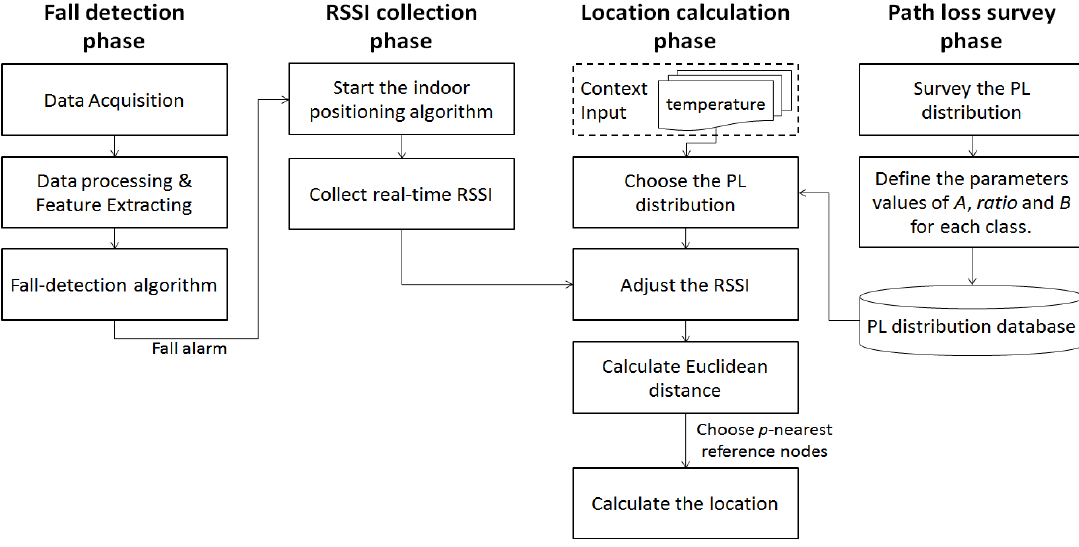
Figure 4. The flow diagram of ZigBee-based location-aware fall detection